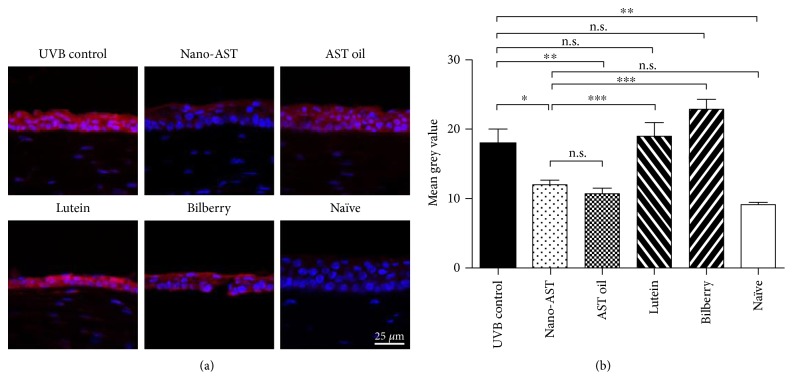
Assessment of reactive oxygen species (ROS) levels by dihydroethidium (DHE) staining. (a) Cell nuclei were stained with DAPI (blue). ROS were investigated through DHE staining. Upon reaction between ROS and DHE, DHE form, a red fluorescence, produced, namely, 2-hydroxyethidium. ROS were strongly detected in the UVB-irradiated groups, lutein, and bilberry. In contrast, the nano-AST group displayed a weak signal of ROS, with some reduction observed in AST oil as well. Scale bar = 25 μm. (b) DHE staining quantification revealed significantly reduced luminosity values in nano-AST- (p < 0.05) and AST oil- (p < 0.01) treated groups. Lutein and bilberry extract administration did not result in significant reduction of ROS signal compared to the UVB control. n = 8 (eyes) per group. n.s., p > 0.05; ∗p < 0.05; ∗∗p < 0.01; ∗∗∗p < 0.001.